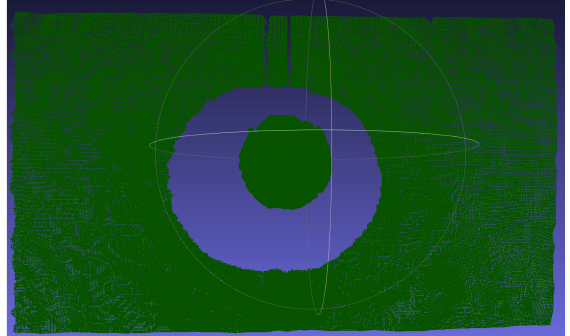
Figure 6. Visualization of experiment 1 in Meshlab.